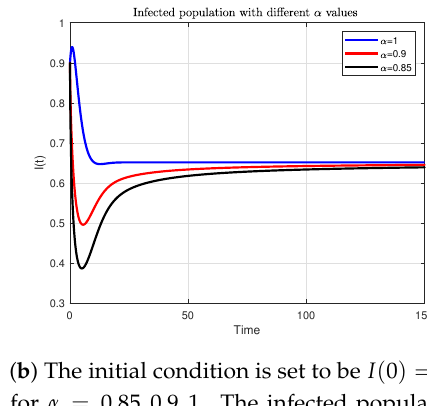
( a ) The initial condition is set to be S ( 0 ) = 1.6 ( b ) The initial condition is set to be I ( 0 ) = 0.6 for α = 0.85,0.9,1. The susceptible population for α = 0.85,0.9,1. The infected population converges asymptotically to S ∗ = 1.4142. converges asymptotically to I ∗ = 0.6515. Figure 2. Numerical simulations of the model (5) with different α values and the Holling type III function response. For the set of parameters Ψ = 0.75, µ = 0.3, η = 0.1, β = 0.3, ρ = 0.15, δ = 0.05 and τ = 0.1 we have R 0 = 0.551 < 1. Thus, the disease-free steady-state solution is asymptotically